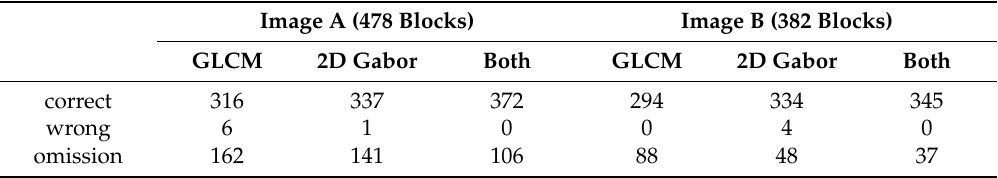
Table 2. The comparison of extraction results under three different conditions.